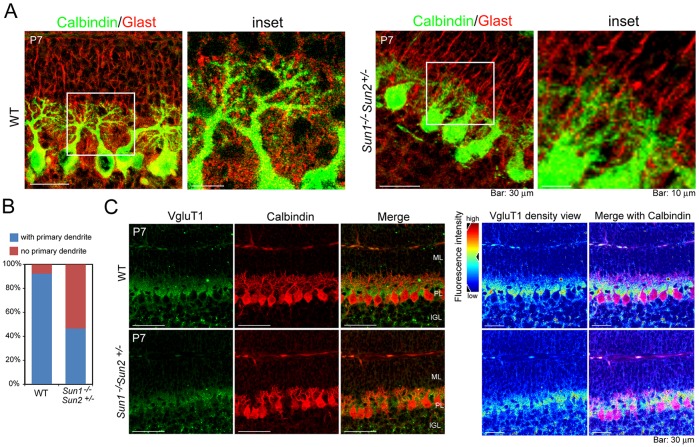
Aberrant synaptic patterning in the developing cerebellum upon deficiency of Sun genes. (A) Cerebellum sagittal sections from 7-day-old WT and Sun1−/−Sun2+/− mice were immunostained for calbindin (green) to mark Purkinje cells and Glast (red) to label radial glia. (B) Quantification of primary dendrites of P7 WT and Sun1−/−Sun2+/− Purkinje cells, which show promising primary dendritic outgrowth. Approximately 50 Purkinje cells were quantified for each genotype. (C, left panel) Immunofluorescent staining of calbindin (red) and VgluT1 (green) in P7 WT and Sun1−/−Sun2+/− cerebellum. (Right panel) Density view of VgluT1. The color code of the expression levels is presented on the left. The ‘warm’ colors represent high expression levels, and the ‘cold’ colors represent low expression levels.